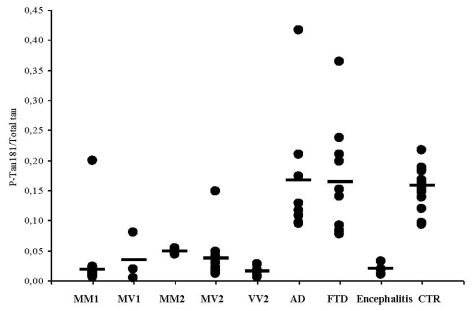
Phosphotau181/tau ratio in sCJD subtypes, FTD, AD, and herpes encephalitis.